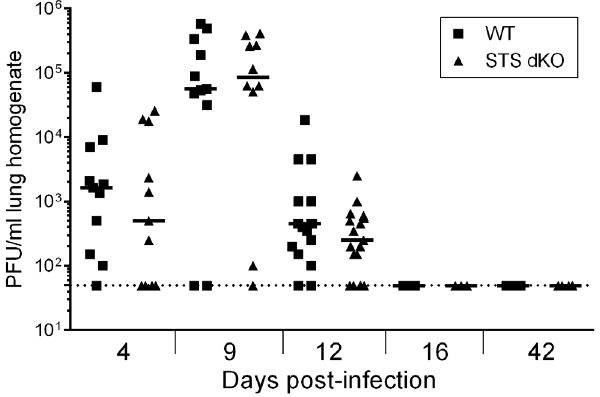
Figure 3. Sts dKO T cells do not alter the kinetics or levels of acute replication in the lungs. Sts dKO and C57BL/6 WT mice were infected 1000 PFU of MHV68 by the intranasal route. Lungs were harvested and disrupted at the indicated timepoints to quantitate levels of pre-formed infectious virus. Bar indicates median of log 10 trans- formed data; dashed line indicates limit of detection. 3–8 animals are included per replicate experiment, n=3 for 4 dpi, n=2 for 9 dpi, n=2 for 12 dpi, and n=1 for 16 and 42 dpi; no significant differences were found based on Mann-Whitney non-parametric t-tests.